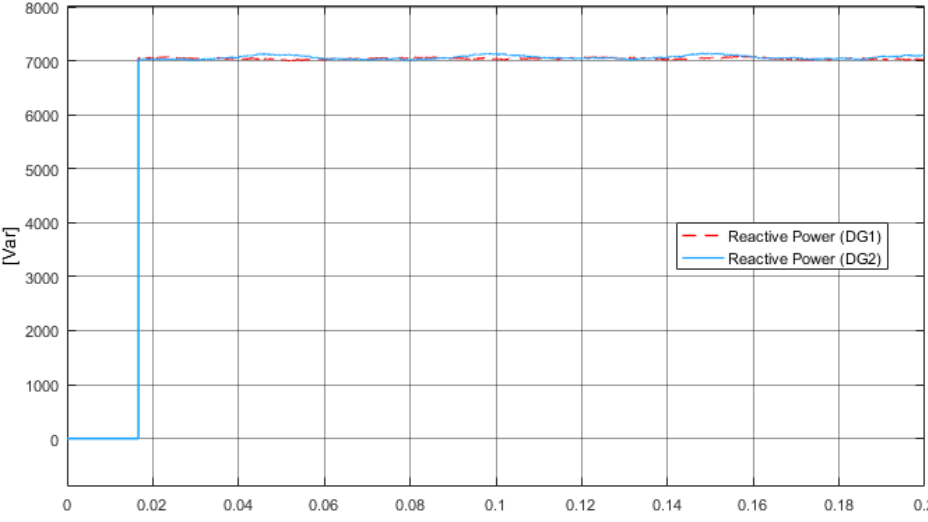
Figure 14. The waveform of the reactive power of DGs for parallel operation in GC mode.